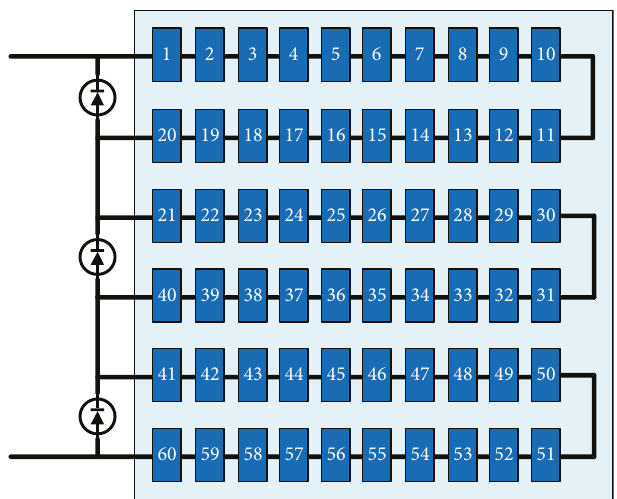
Figure 5: Internal wiring diagram for the module. The module consists of 60 cells in